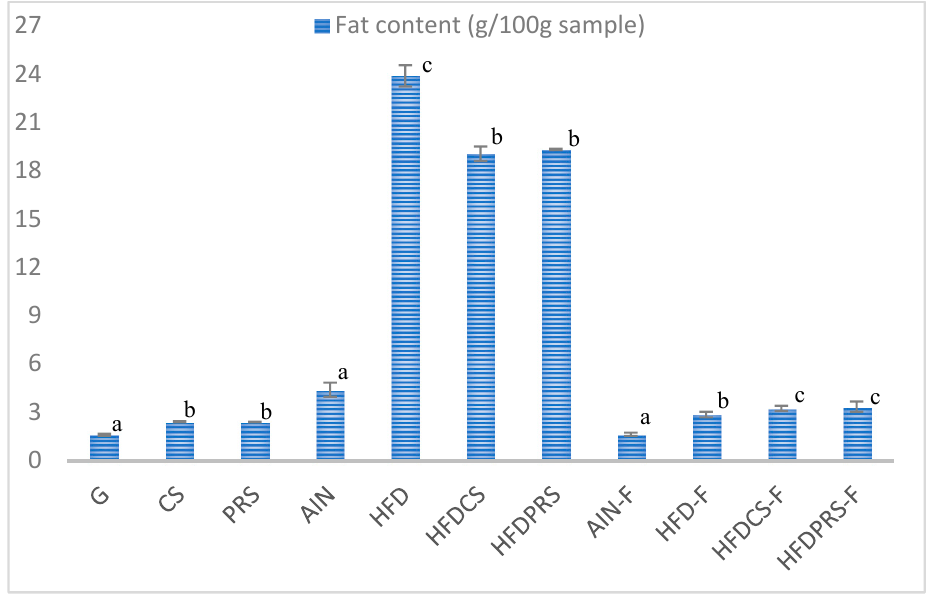
Figure 2. Total fat content in different forms of buckwheat. Mean values with different letters above the bars differ statistically, p < 0.05. G—grains, CS—control sprouts, PRS—probiotic-rich sprouts; AIN—group fed with the basic diet AIN-93M; HFD—group fed with the basic diet AIN 93M with the addition of lard; HFDCS—group fed with the basic diet AIN-93M with the addition of lard and lyophilisate from control sprouts; HFDPRS—a group fed with the basic diet AIN-93M with the addition of lard and modified buckwheat sprouts lyophilisate. AIN-F—feces of the AIN group, HFD-F—feces of the HFD group, HFDCS-F—feces of the HFDCS group, HFDPRS-F—feces of the AIN group.